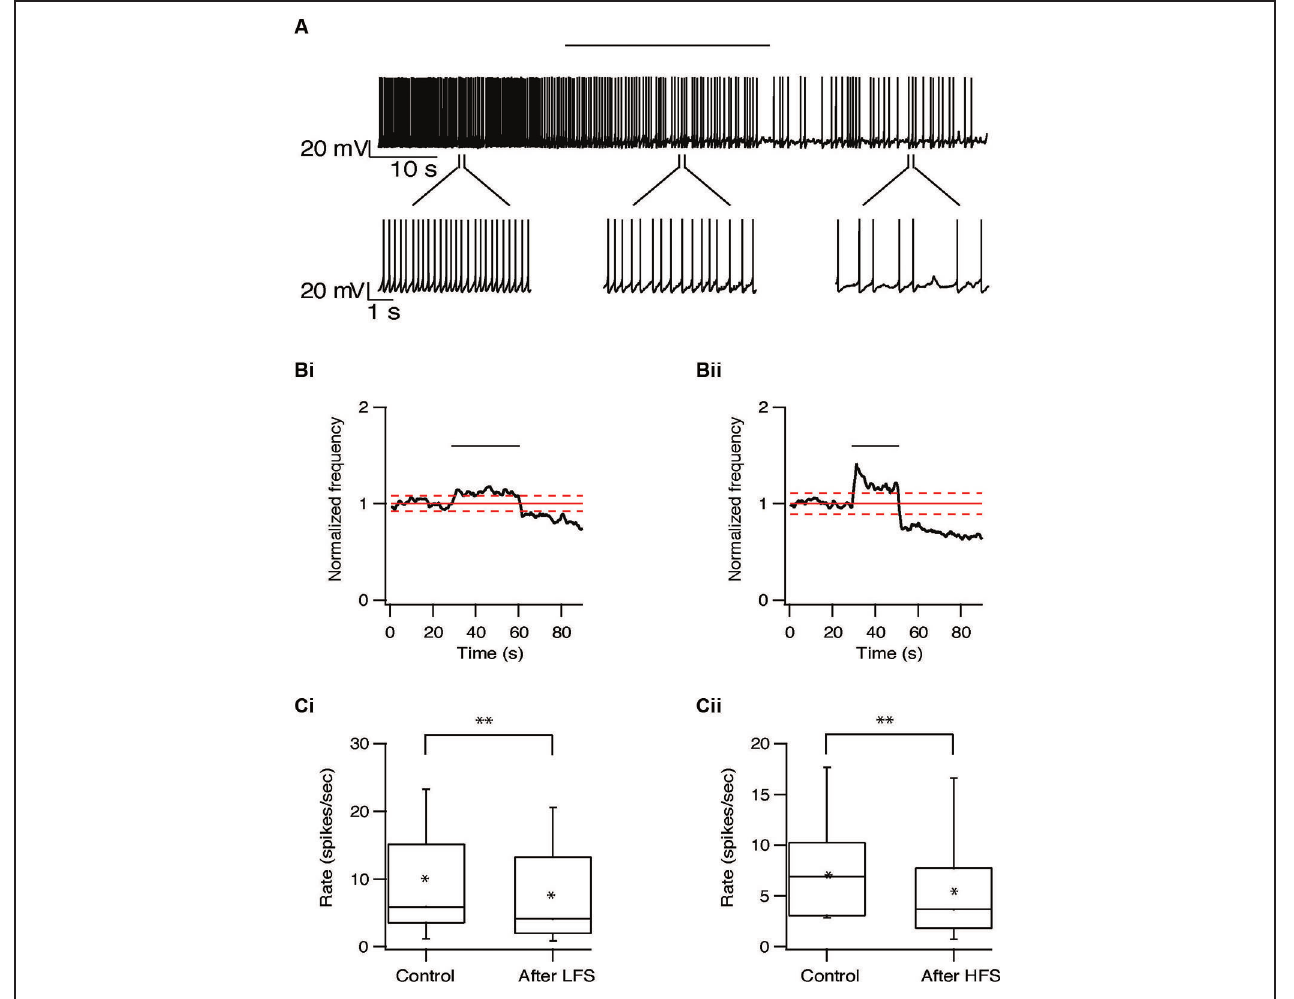
FIGURE 6 | Long-term depression of the STN induced by repetitive stimulation. (A) Representative recording from a subthalamic neuron during 10 Hz stimulation of the STN. Stimulation artifact was removed to improve visualization of the neuronal activity. Horizontal line above indicates the stimulation period. (B) Changes in normalized population firing rate of